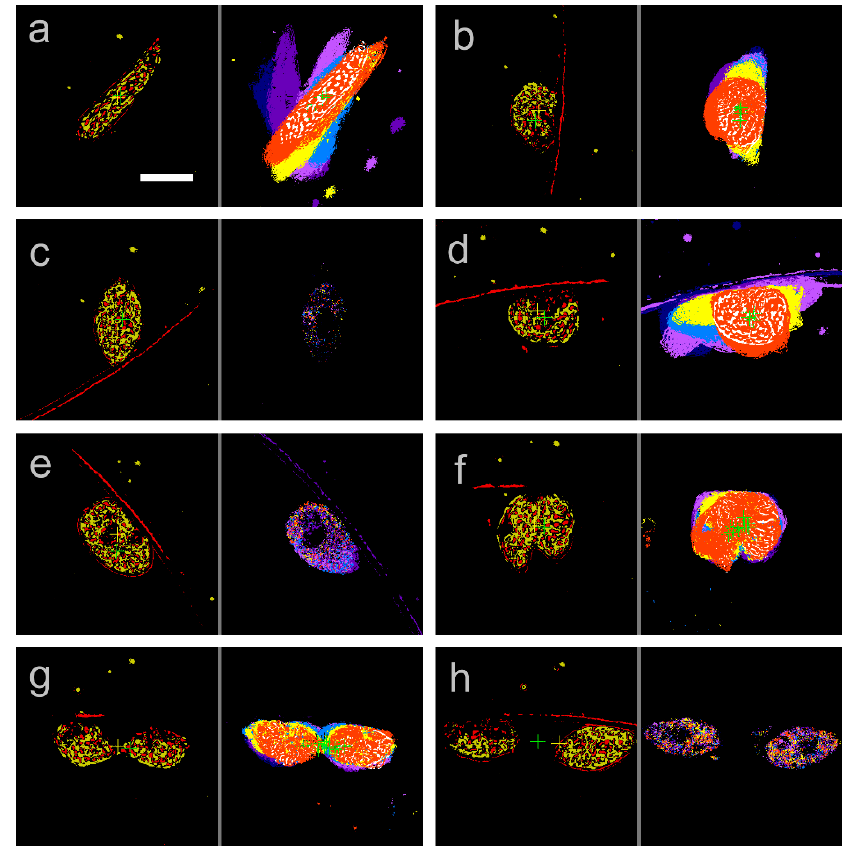
Figure 4. Contrast ( left ) and trace image ( right ) observed at ( a ) 10.0 h, ( b ) 15.0 h, ( c ) 16.1 h, ( d ) 20.0 h, ( e ) 21.7 h, ( f ) 23.3 h, ( g ) 23.5 h, and ( h ) 26.0 h. The time point of each image is given in Figure 3 as vertical lines. Cross marks in the images are the center of gravity of non-zero pixels for the purpose of XY-stage control. Scale bar, 20 μ m.